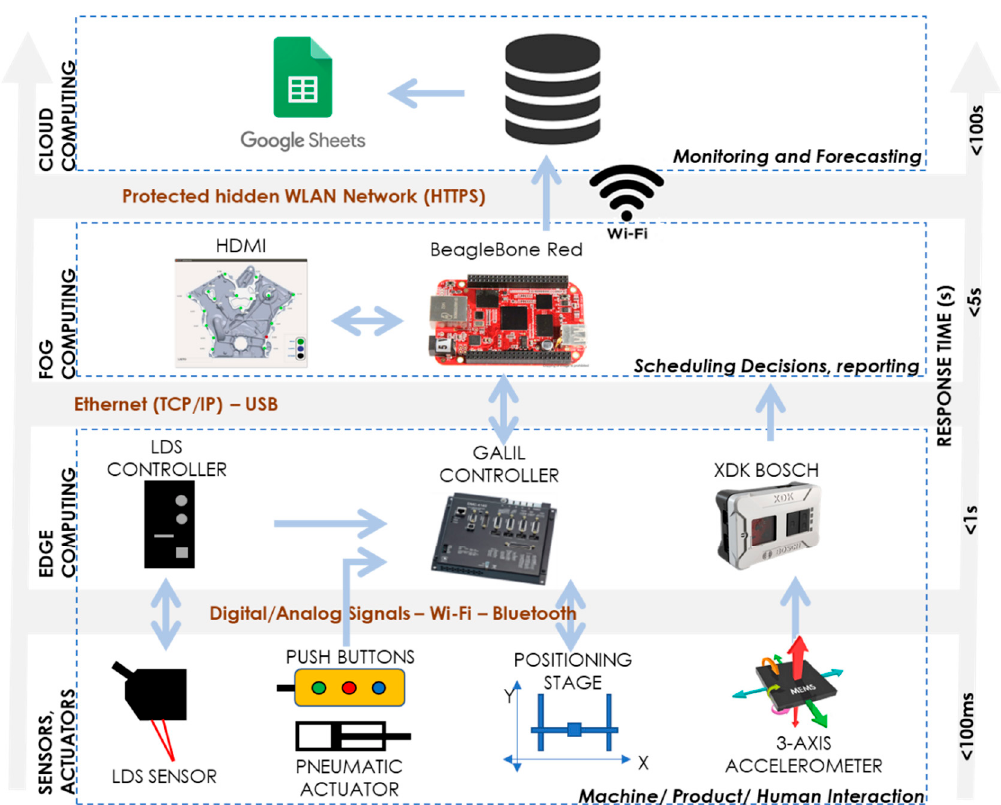
Figure 10. Control architecture of In-line Measurement machine. Connectivity, data flow and distribution of analysis, and support for decision making.